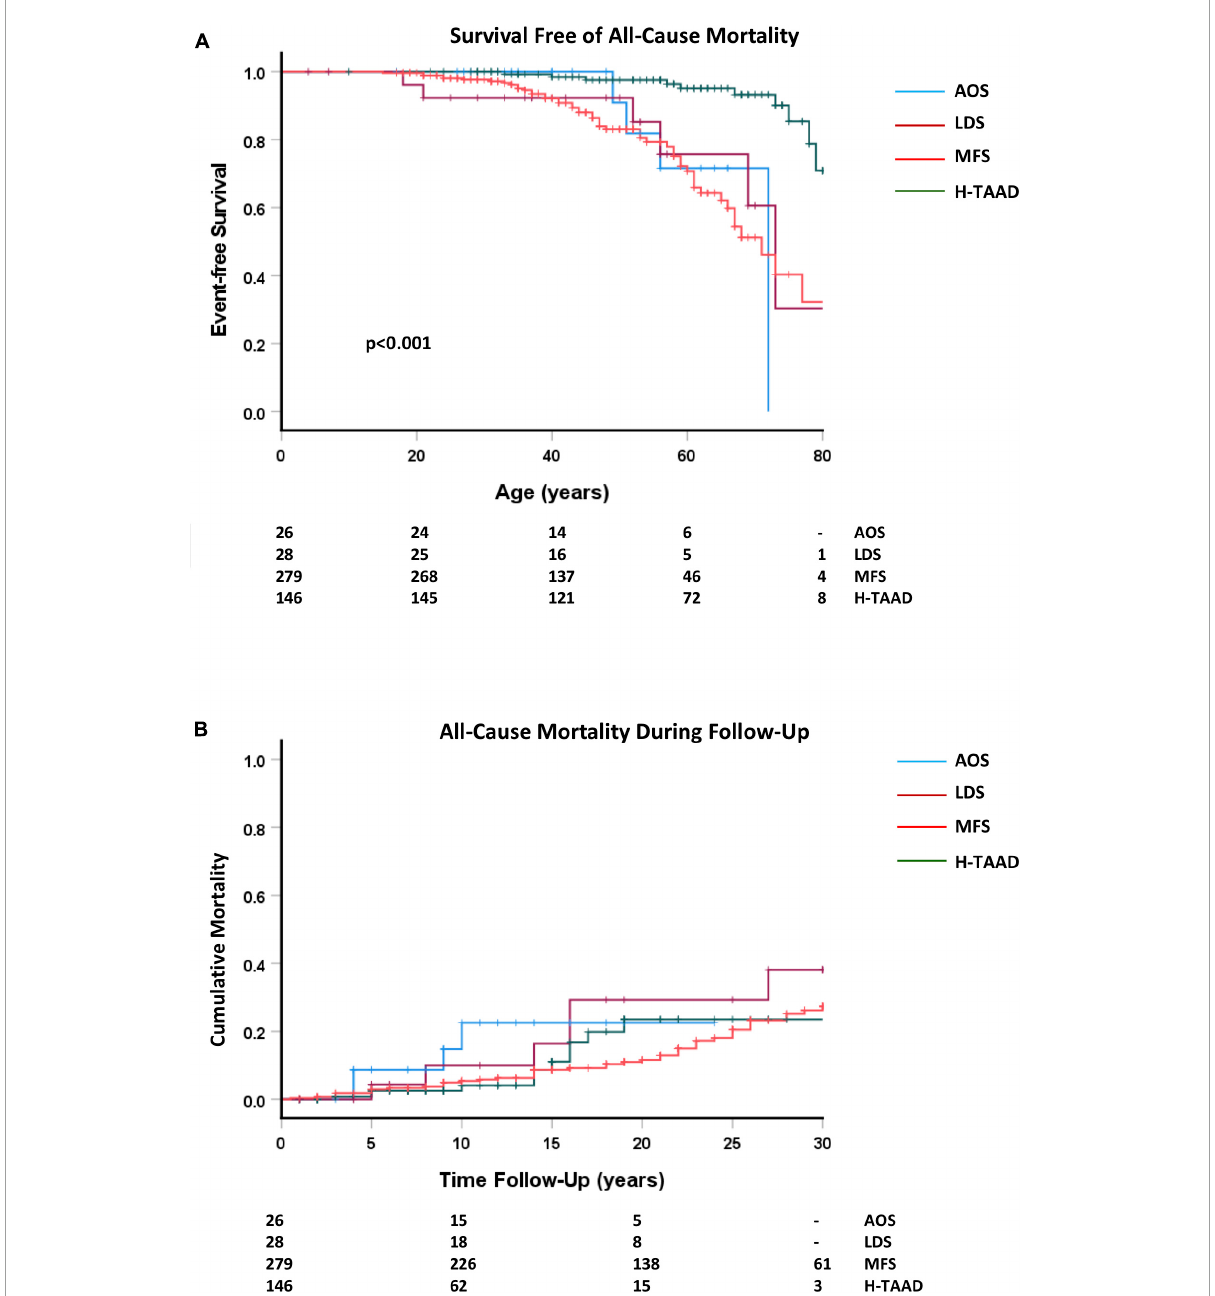
The outcomes in MFS and H-TAAD groups according to medical treatment are further described in Supplementary Table 1 , with comparison between those taking nil treatment, beta-blockers only, angiotensin receptor blockers only or combined treatment. In MFS, the incidence of death